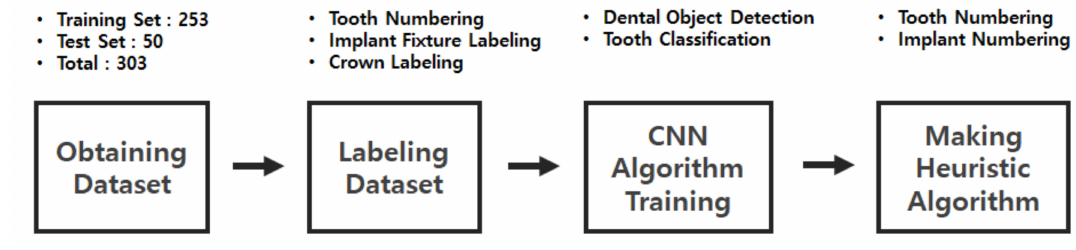
Figure 2. Study flow of teeth and implant